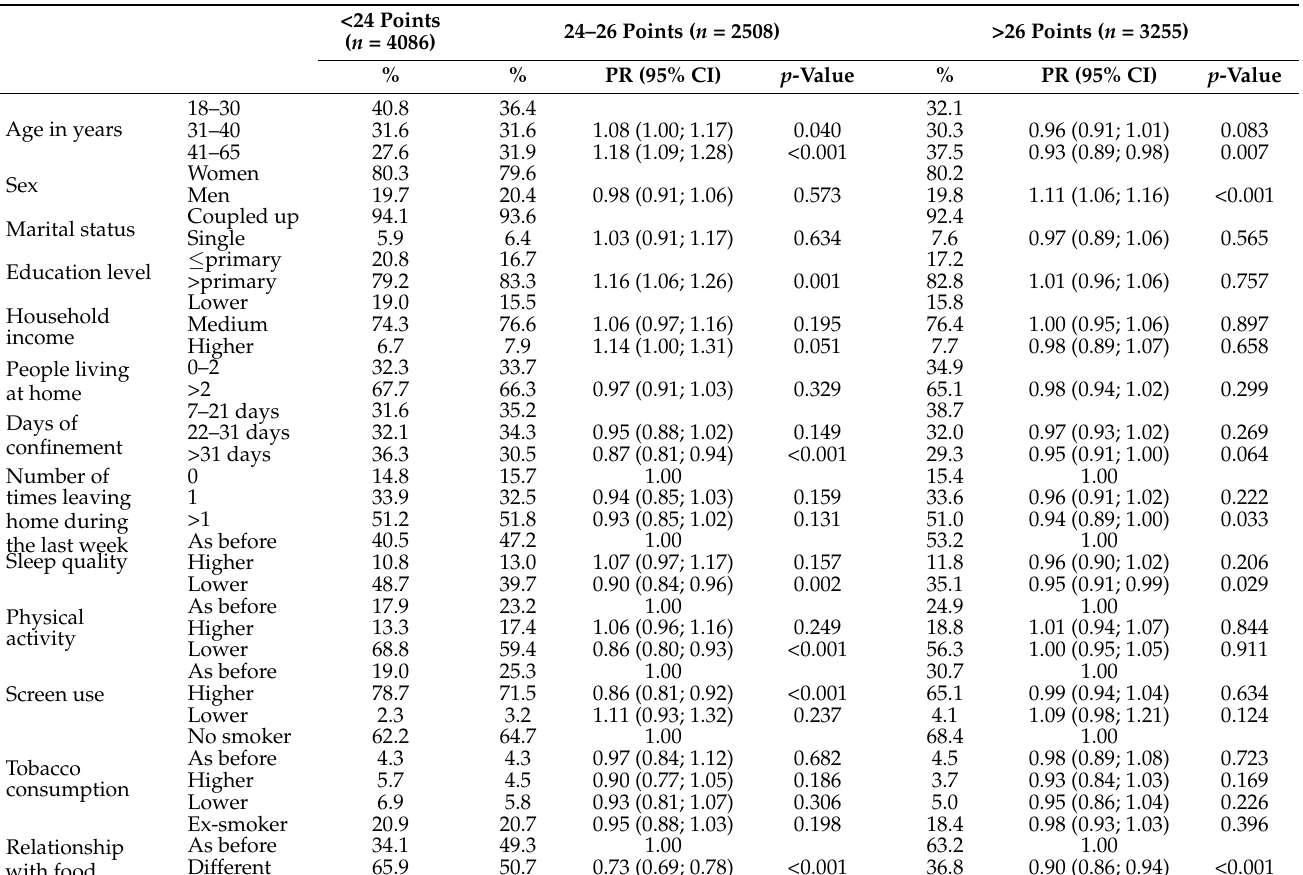
Table 4. Associated factors with medium (24–26 points) and high (>26 points) scores of uncontrolled eating in the participants in the CoV-Eat project ( n =